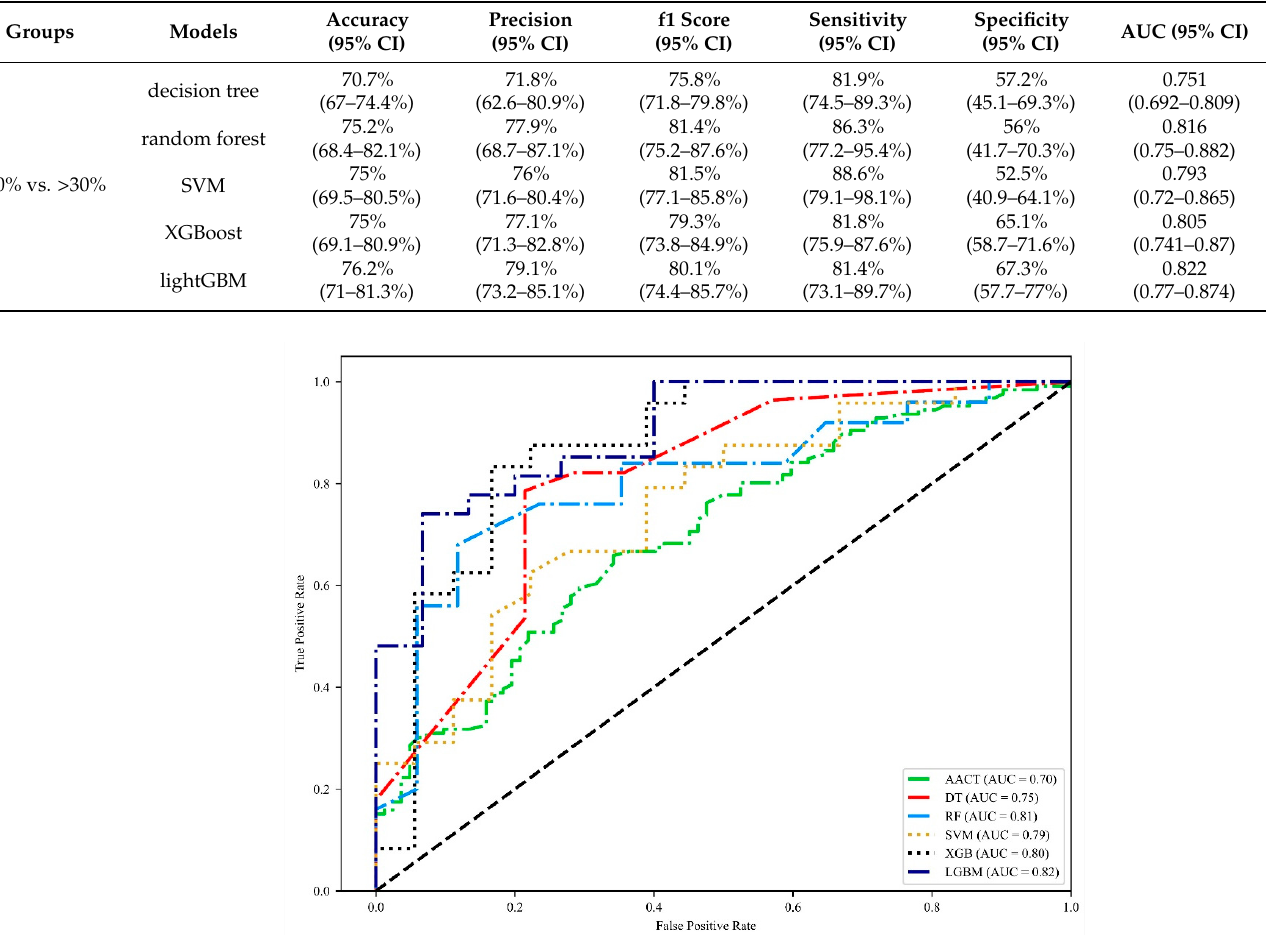
Figure 2. The comparison of ROC plot in AACT and five different models to identify severity of CAD.